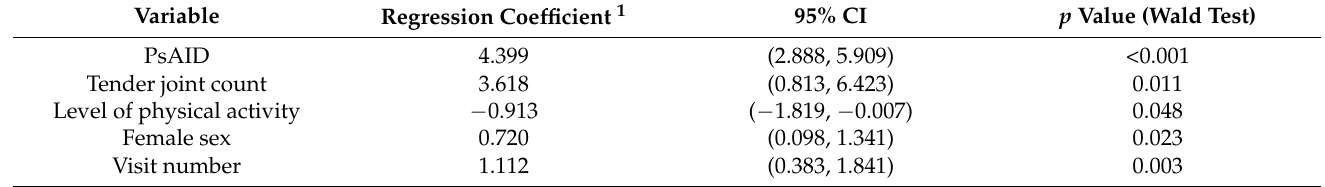
Table 2. Variables associated with moderate-high activity selected in the logistic regression analysis.